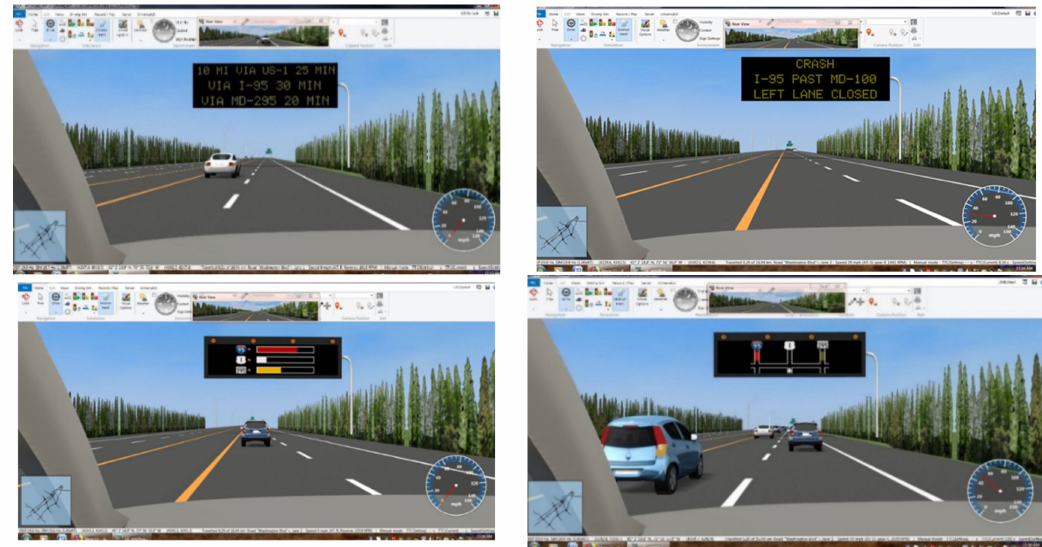
Figure 3. A screenshot of the simulated driving environment and some DMS